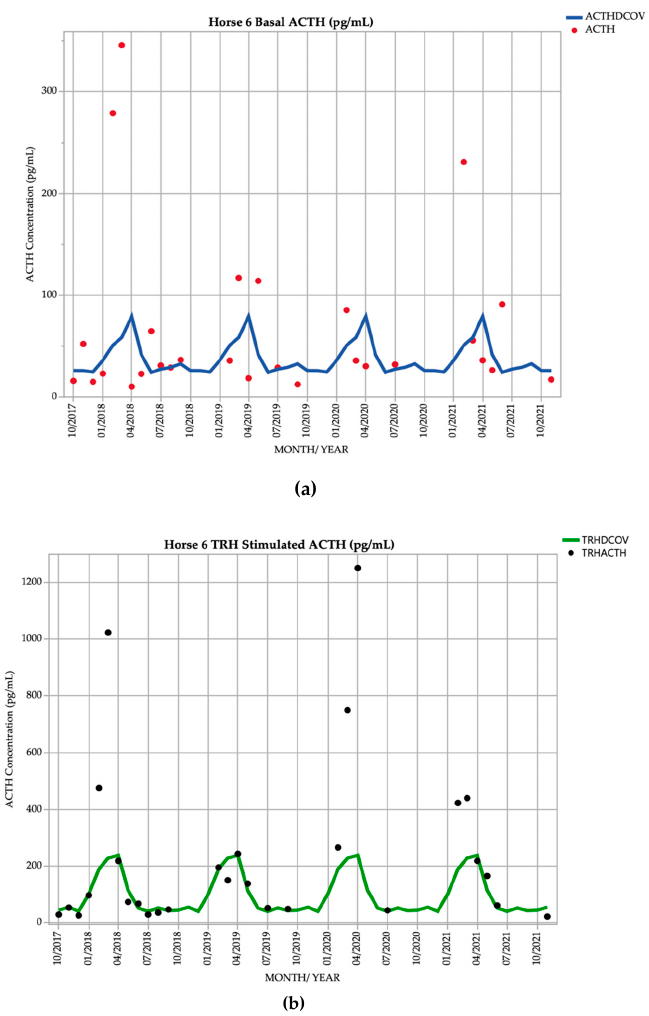
Figure 6. Monthly ACTH concentration (pg/mL) in Horse 6 (16 ‐ year ‐ old Standardbred mare), compared to locally derived, seasonally adjusted DCOV [2]. (a) Basal ACTH concentrations (red points) and basal ACTH DCOV (blue line) (b) TRH ‐ stimulated ACTH concentrations (black points) and TRH ‐ stimulated ACTH DCOV (green line).